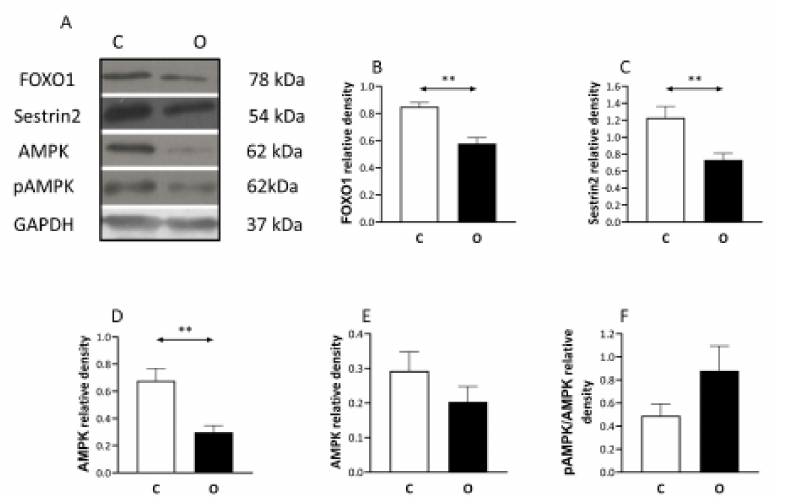
Figure 3. Pro-catabolic pathway associated proteins are down-regulated during overload. Because hypertrophy is not just dependent on anabolic but also on catabolic signaling, the level of forkhead box class O protein 1 (FOXO1), Sestrin 2, AMP, pAMPK, were measured and found to be decreased in the muscle which is exposed to overload-induced hypertrophy, indicating the down-regulation of catabolic pathways during overload-induced hypertrophy. ( A ) panel shows the selected immunoplot signals, and ( B – F ) panels show the densitometric results of nine samples in each group. C: control group, O: Overloaded group, n = 9, ** p < 0.01, Results are expressed as mean ±